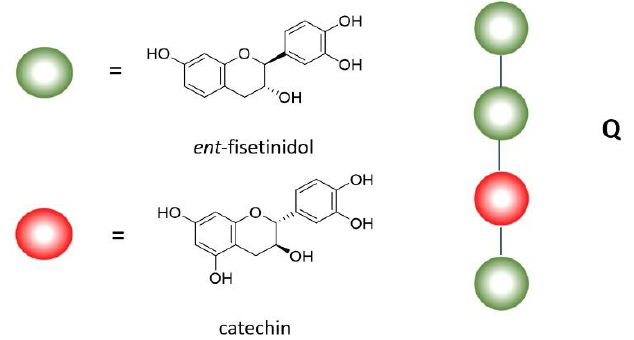
Figure 2. Most represented structures in Q.